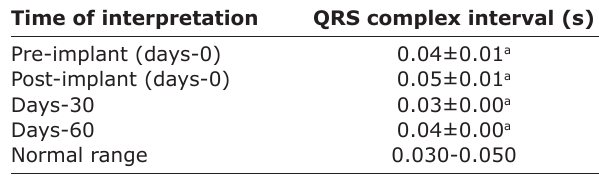
Table-9: The average QRS complex intervals of the pigs.